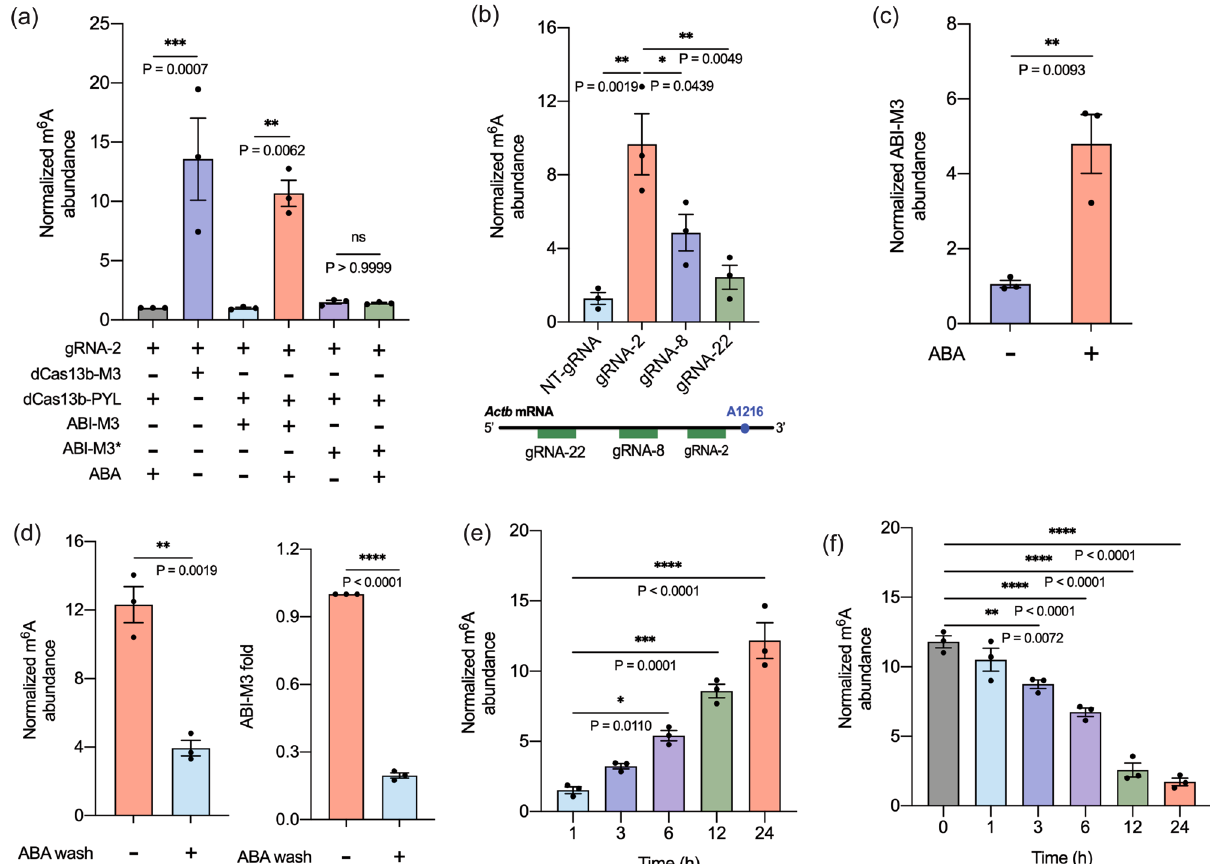
Fig. 2 ABA-induced m 6 A writing at the Actb mRNA A1216 site in HEK293T cells. a The m 6 A level changes under different treatment conditions using the ABA-inducible or non-inducible m 6 A writing system. b The m 6 A level changes using the ABA-inducible m 6 A writing system with different gRNAs. c The ABI-M3 level changes with or without ABA at the target site. d The m 6 A level (left) and the ABI-M3 level (right) change before or after ABA removal (for 24 h). e The m 6 A enrichment at different time points after adding ABA. f The m 6 A enrichment at different time points after washing out ABA. ABA was added to induce m 6 A writing for 24 h before the time-course experiments of ABA removal. All results were calculated by normalization of data from each sample to that from the condition of dCas13b-PYL plus gRNA-2 and ABA. Values and error bars re fl ect the mean, s.e.m. of three independent biological replicates. P values are shown in the charts are determined by one-way ANOVA. Source data are provided as a Source Data fi